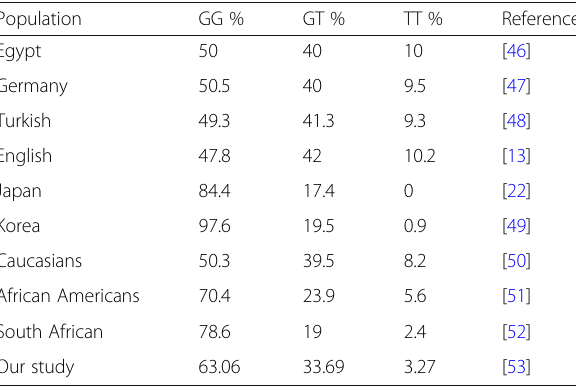
Table 4 Distribution of G894 T eNOS polymorphism among different